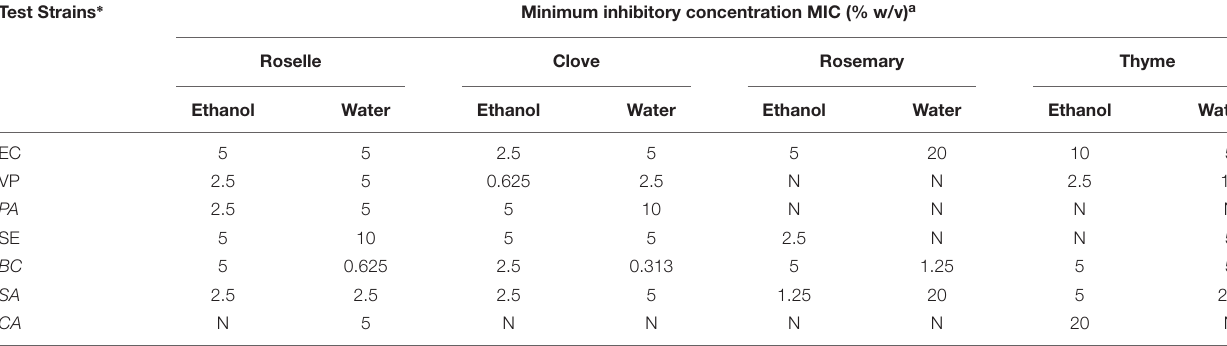
TABLE 3 | The Minimum Inhibitory Concentration (MIC) of plant extracts against the test microorganisms. Test Strains ∗